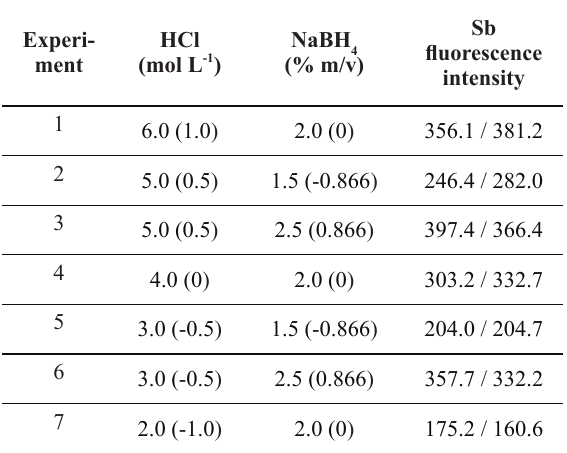
Doehlert design applied to optimization of stibnite